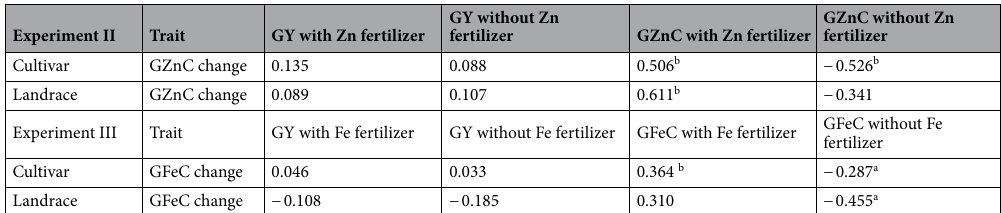
Table 1. Pearson correlation coefficients between changes of grain micronutrient concentration and the other studied traits in wheat landraces (n = 28) and cultivars (n = 65) under Zn and no-Zn application in Experiment II and Fe and no-Fe application in Experiment III. Grain Zn concentration (GZnC), grain Fe concentration (GFeC), grain yield (GY). a and b Significant at the 5% and 1% probability levels,